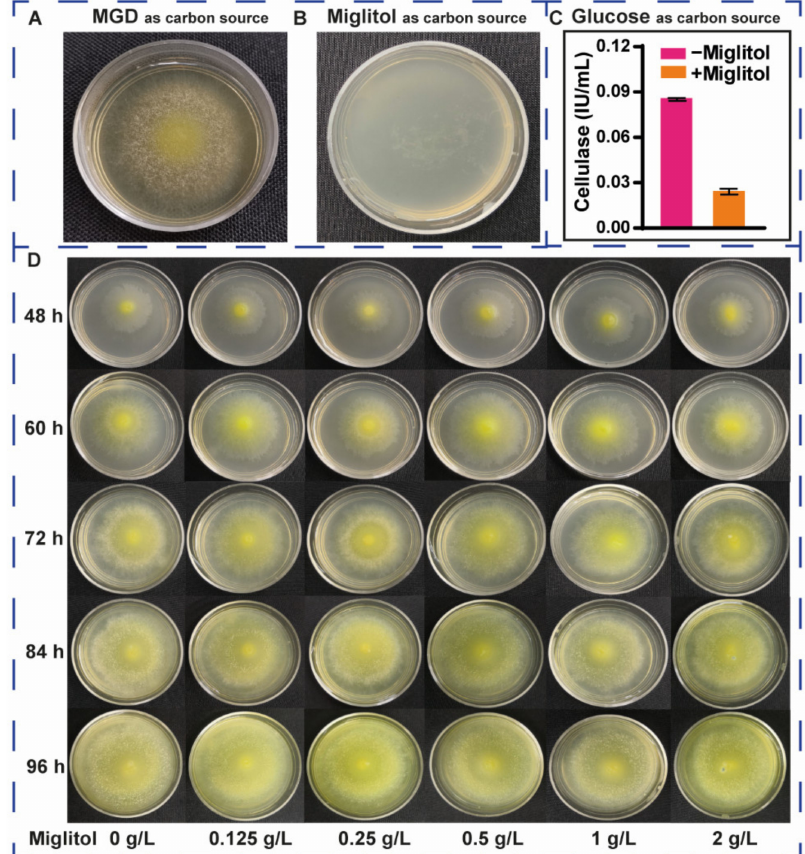
Figure 4. Effects of miglitol on the growth and induction of T. reesei. Colony morphology of T. reesei on plates containing ( A ) 10 g/L MGD or ( B ) 10 g/L miglitol as the sole carbon source; ( C ) Effect of adding miglitol versus no miglitol on the cellulase activity of T. reesei Rut C30 with 10 g/L glucose as the carbon source at 48 h; ( D ) Time-course of the colony morphology of T. reesei grown using 10 g/L MGD as a carbon source on different concentrations of miglitol. The mycelium growth was measured at 12 h